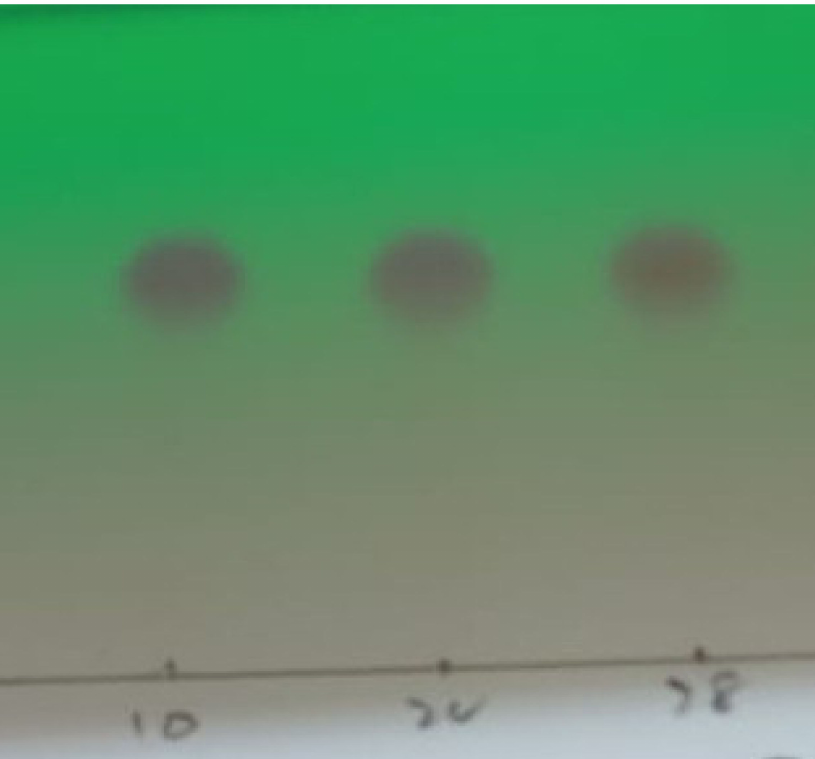
Figure 14. TLC profiling under UV